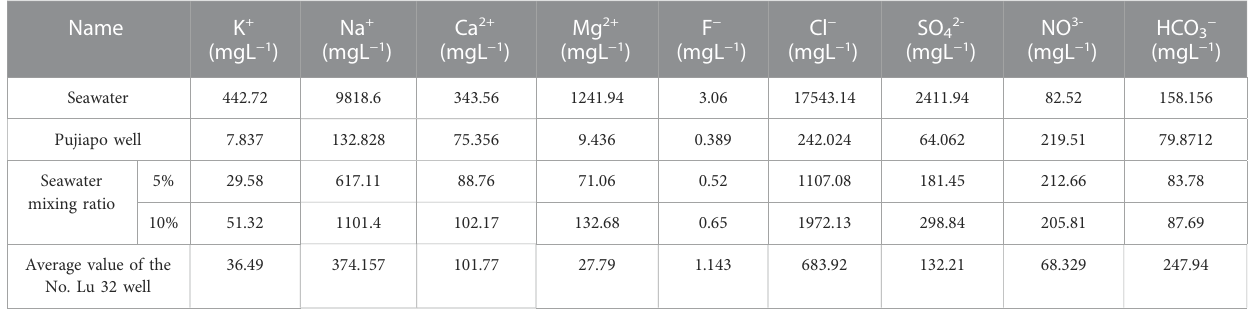
TABLE 2 Seawater and groundwater mixing at different